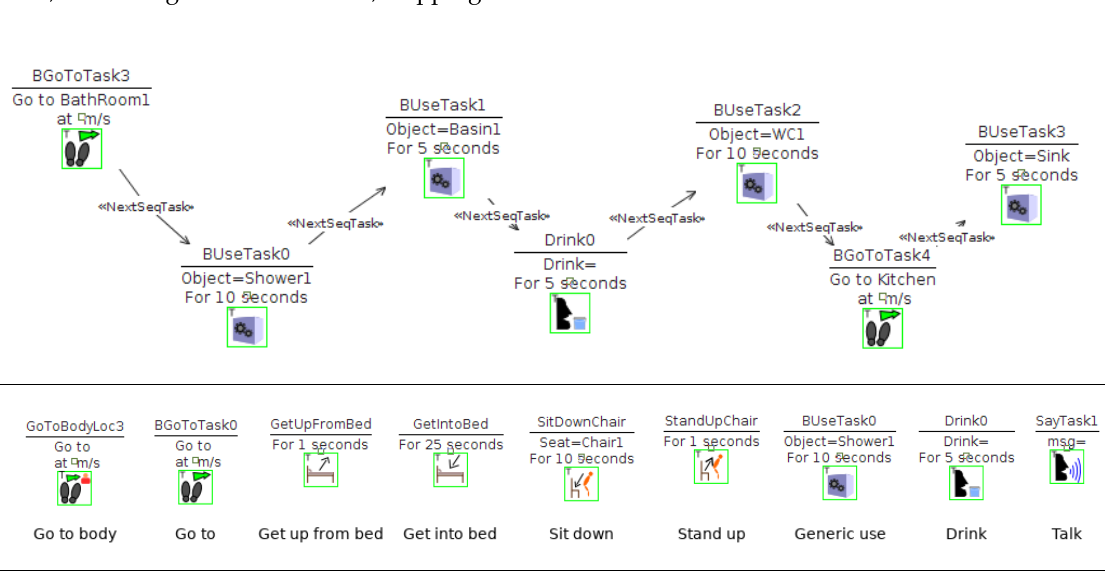
Figure 2. A sequence of tasks involving the bathroom and the